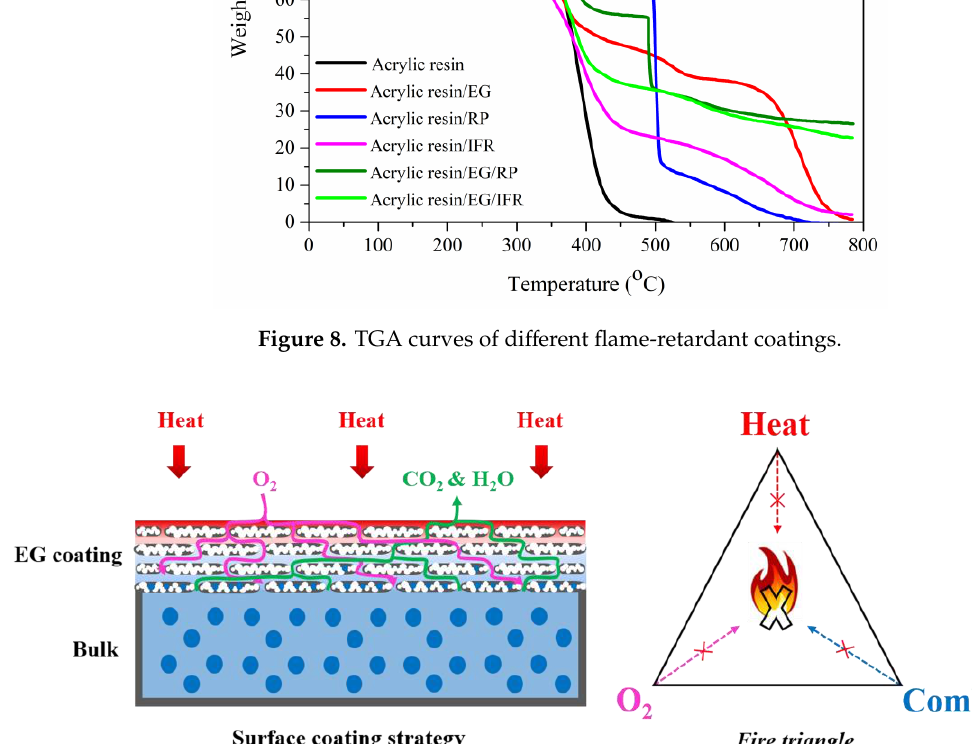
Figure 9. The flame-retardant mechanism of surface-coated SSPCM.